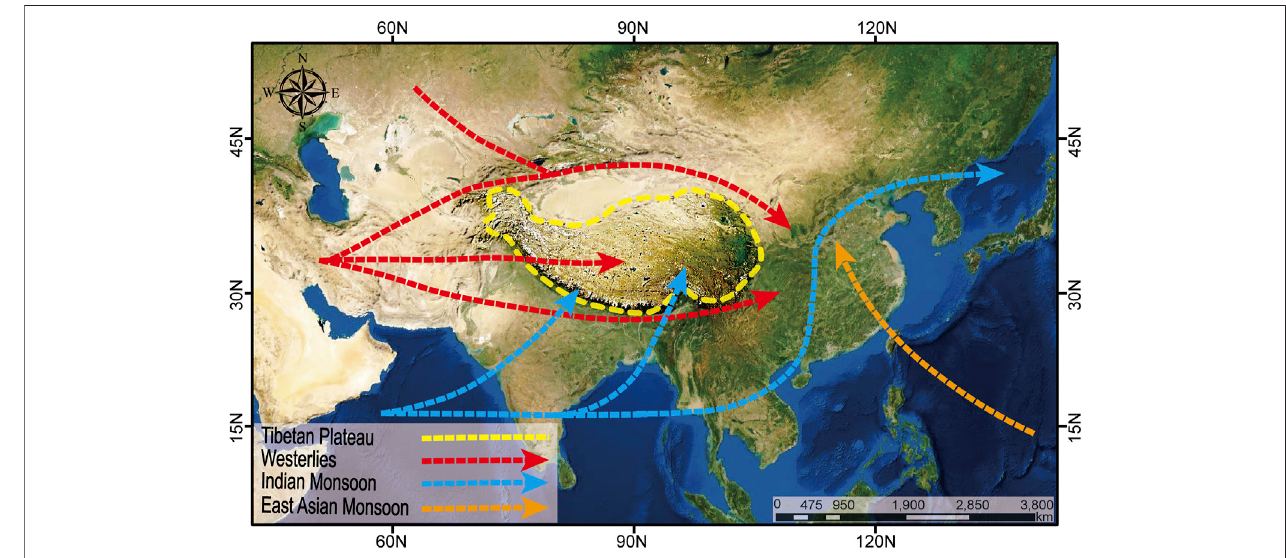
FIGURE 7 | The monsoons of TP (Yang K. et al.,